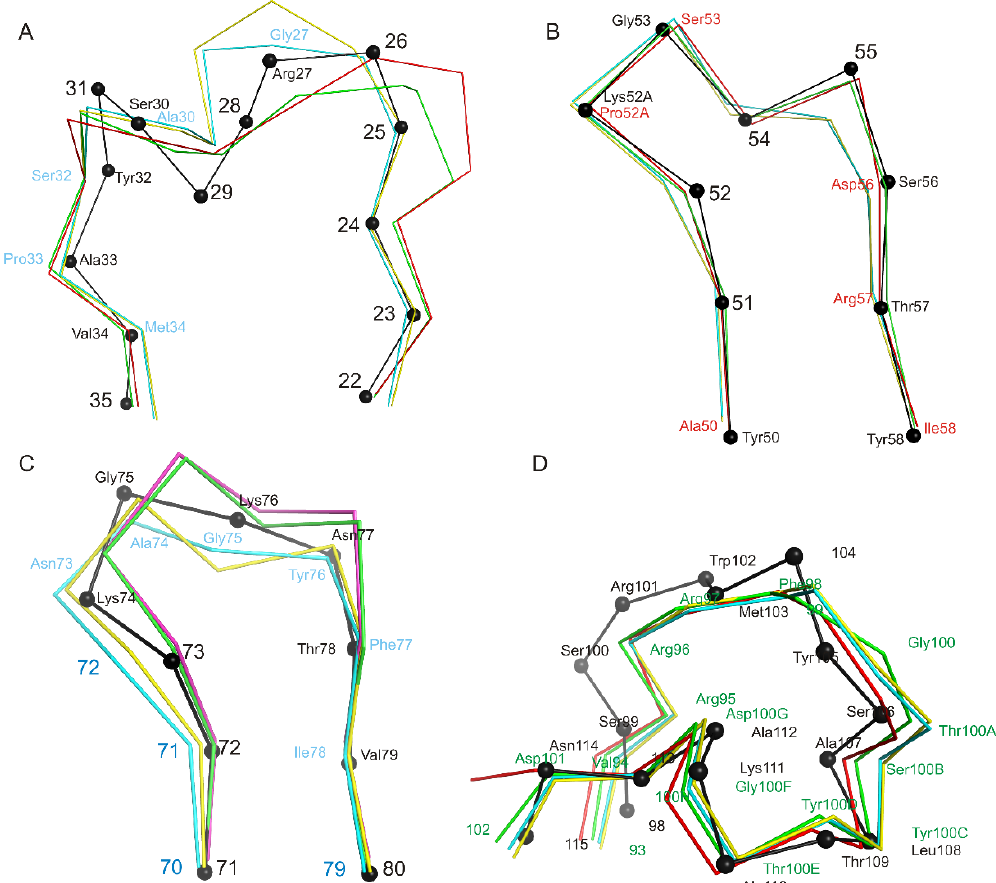
Figure 5. Structural alignment of CDR loops of heavy chains and HFR3 . Structural alignment of Cα atoms of CDR loops of heavy chains and HFR3 of four netakimab Fab fragment molecules and Cα atoms (black) of the most similar structures listed in Table 3 (for CDR loops) and PDB entry 2P45 (for HFR3). Cα atoms of the Fab fragment are colored variously. If amino acids coincide, only position number is provided, whereas both name and position are indicated if they differ. ( A ) CDR-H1, ( B ) CDR-H2, ( C ) HFR3, ( D ) CDR-H3.